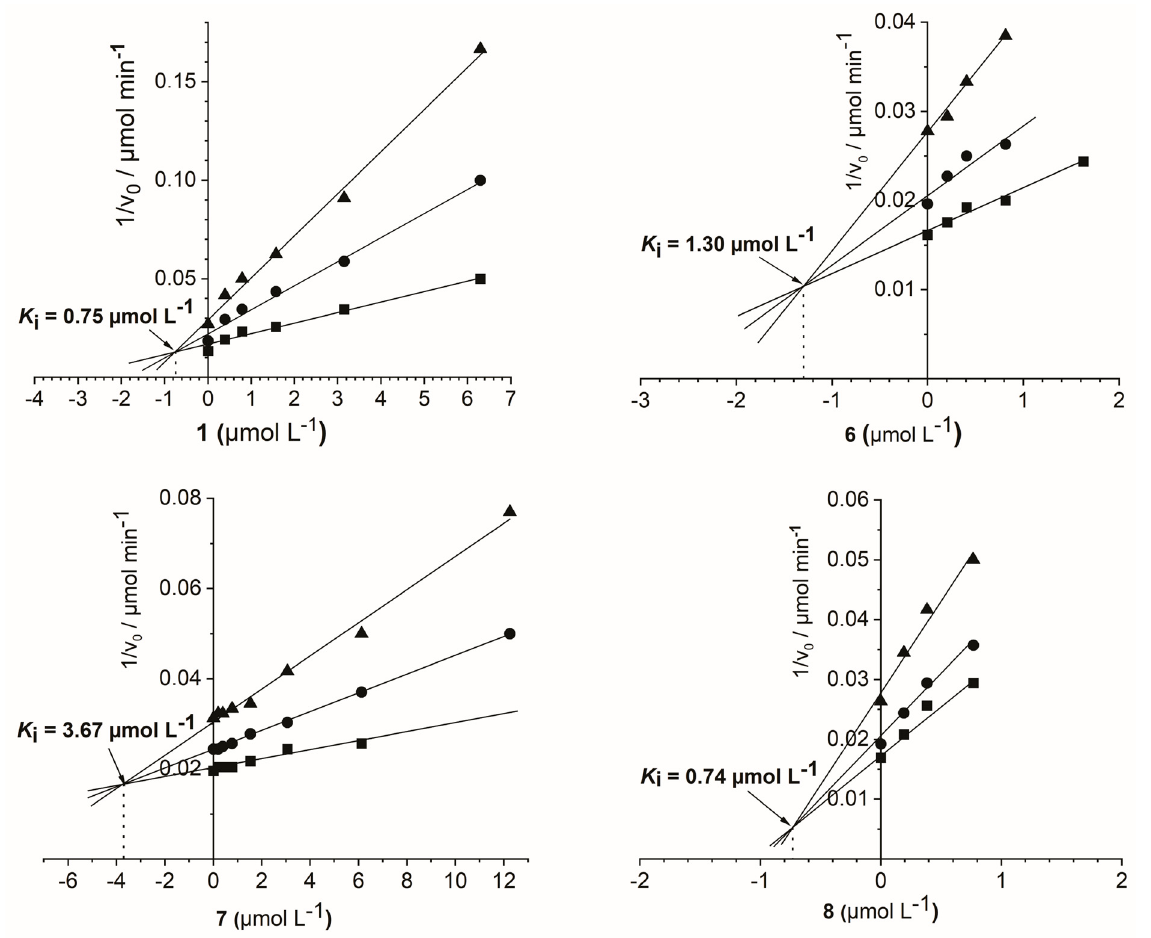
Figure 5. Dixon plots for determination of the type of inhibition and inhibition constants ( K i ) for compounds 1 , 6 , 7 , and 8 towards glutathione S -transferase from horse liver (GST). The concentrations of the substrate 1-chloro-2,4-dinitrobenzene were 200 µM ( ▲ ), 400 µM ( ● ), and 800 µM ( ■ ).